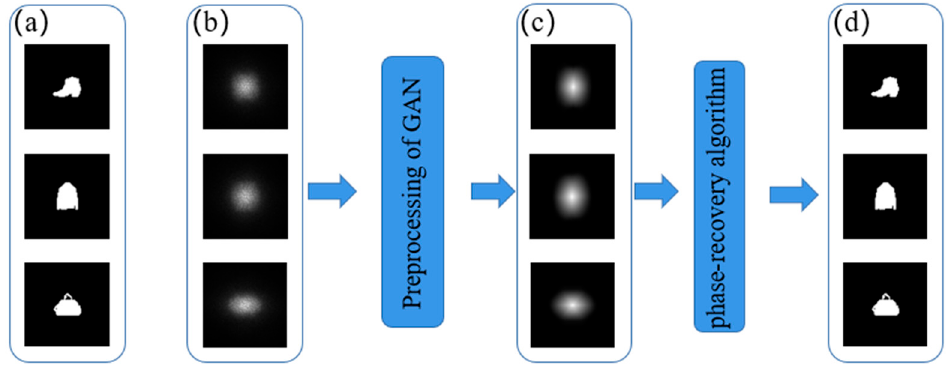
Figure 3. A-eGAN algorithm flow: ( a ) ground truth; ( b ) speckle autocorrelation image; ( c ) high signal-to-noise autocorrelation image output by the deep-learning model; and ( d ) reconstruction result of phase recovery.